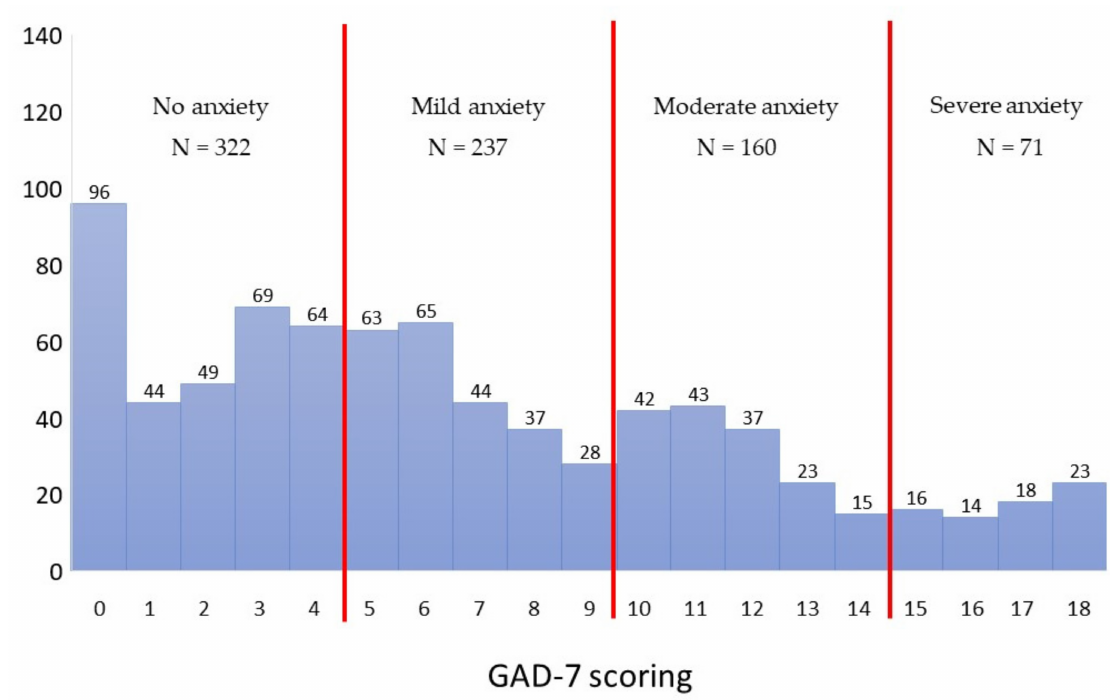
Figure 1. Distribution of GAD-7 scoring ( N = 790).